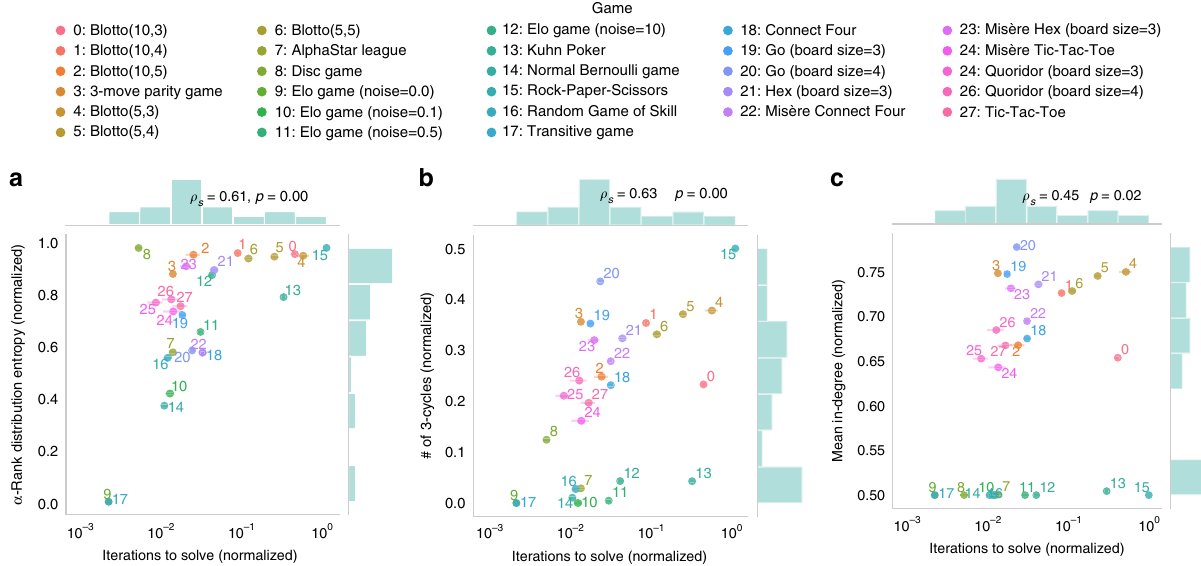
Fig. 9 Response graph complexity vs. computational complexity of solving associated games. Each fi gure plots a respective measure of graph complexity against the normalized number of iterations needed to solve the associated game via the Double Oracle algorithm (with normalization done with respect to the total number of strategies in each underlying game). The Spearman correlation coef fi cient, ρ s , is shown in each fi gure (with the reported two-sided p -value rounded to two